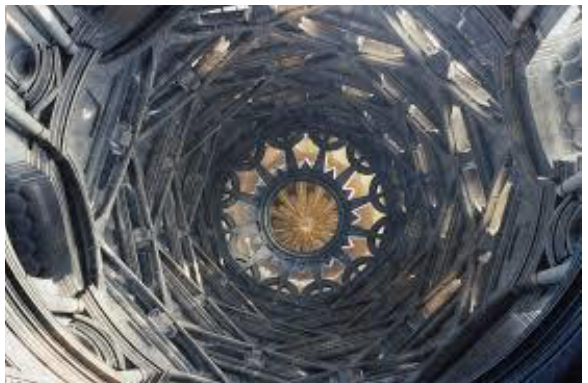
Fig.14 St. Francis from Paola - normal view (Maignan, Trinità dei Monti Rome, 1642)